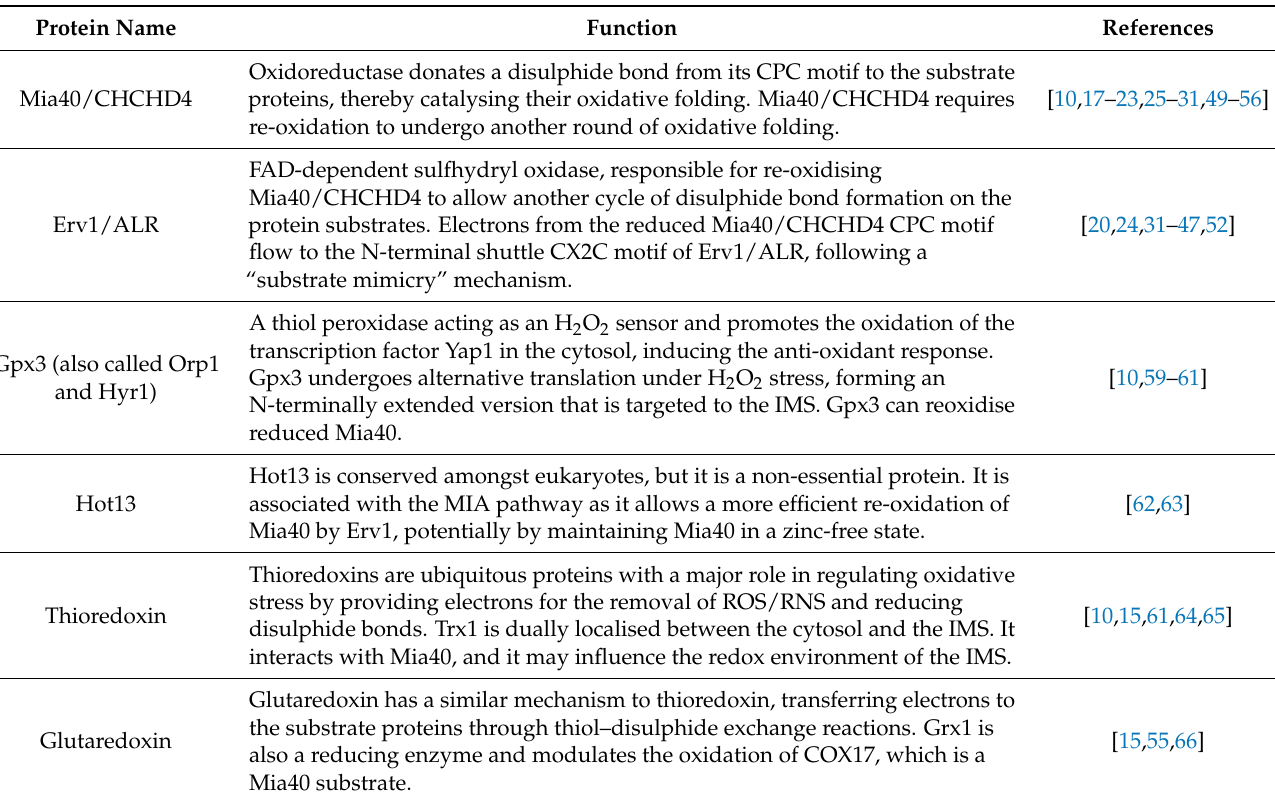
Table 1. Important proteins involved in redox regulation and signalling in the mitochondrial IMS discussed in this review. Protein Name